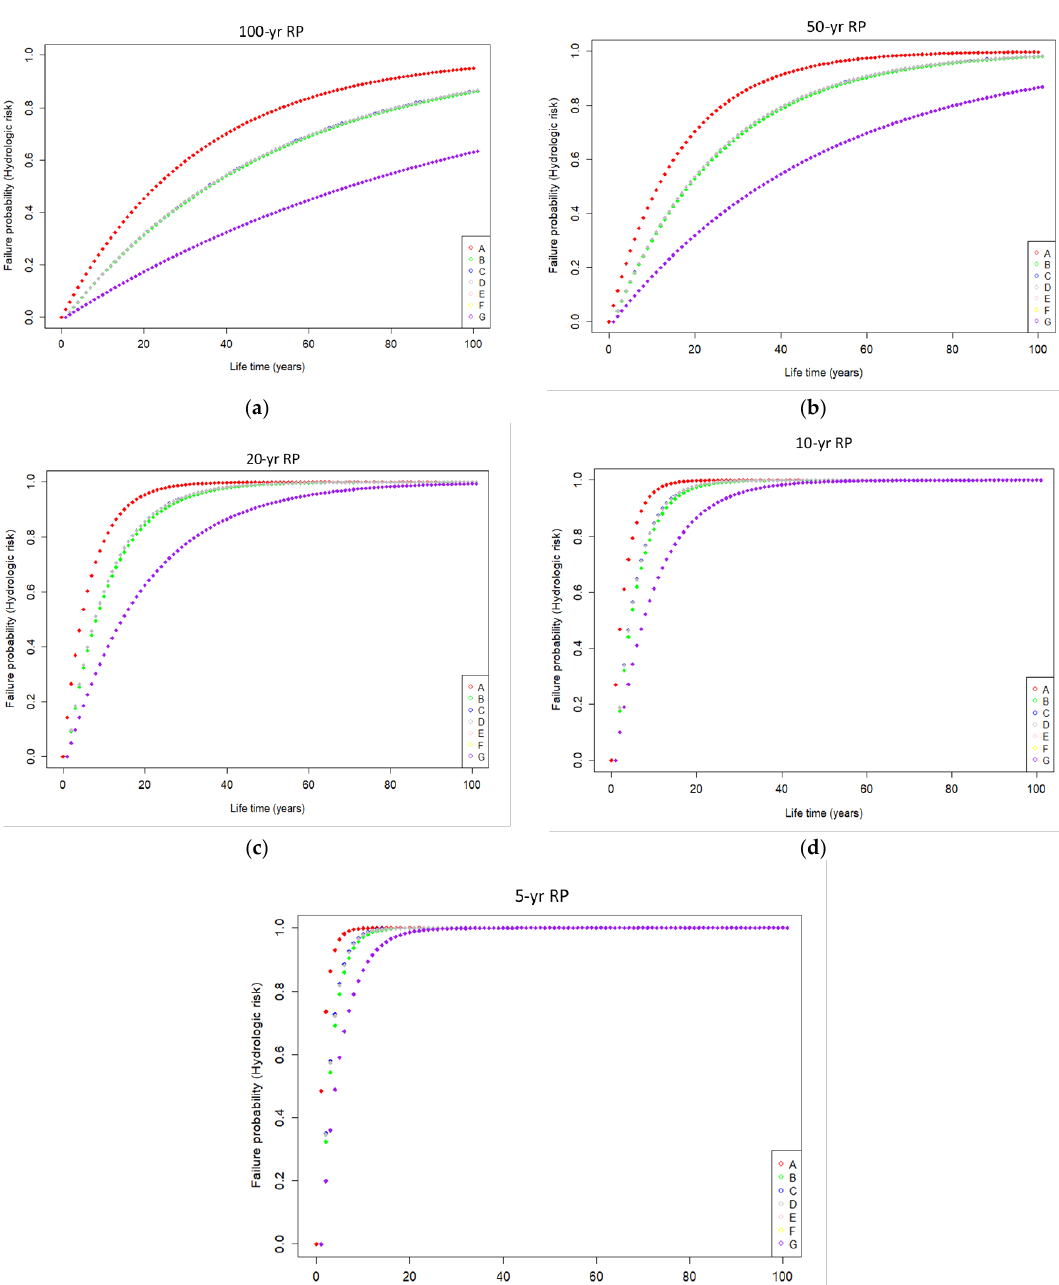
Figure 3. Assessments in the hydrologic risk of CF events for return periods (RPs) ( a ) 100 years, ( b ) 50 years, ( c ) 20 years ( d ) 10 years, ( e ) 5 years [Note: A [red colour] — describing trivariate CF hazard scenario for OR-joint case; B [green colour]—describing bivariate CF hazard scenario between flood pair rainfall and storm surge for OR-joint case; C [blue colour]—describing bivariate CF hazard scenario for flood pair storm surge and river discharge for OR-joint case; D [grey colour]—describing bivariate CF hazard scenario for flood pair rainfall and river discharge for OR-joint case; E [pink colour]—describing univariate hazard scenario through rainfall events; F [yellow colour]—describing univariate hazard scenario through storm surge events; G [purple colour]—describing univariate hazard scenario through river discharge